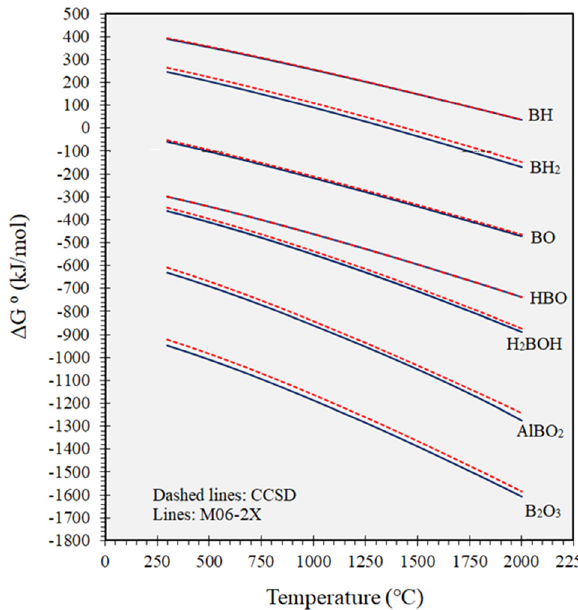
Figure 2: Gibbs free energy for selected gaseous compounds cal - culated by M06 - 2X and CCSD ( T )